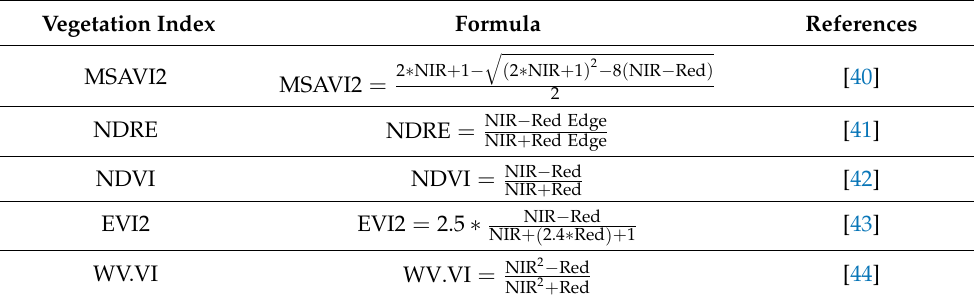
Table 4. Vegetation indexes formulas and